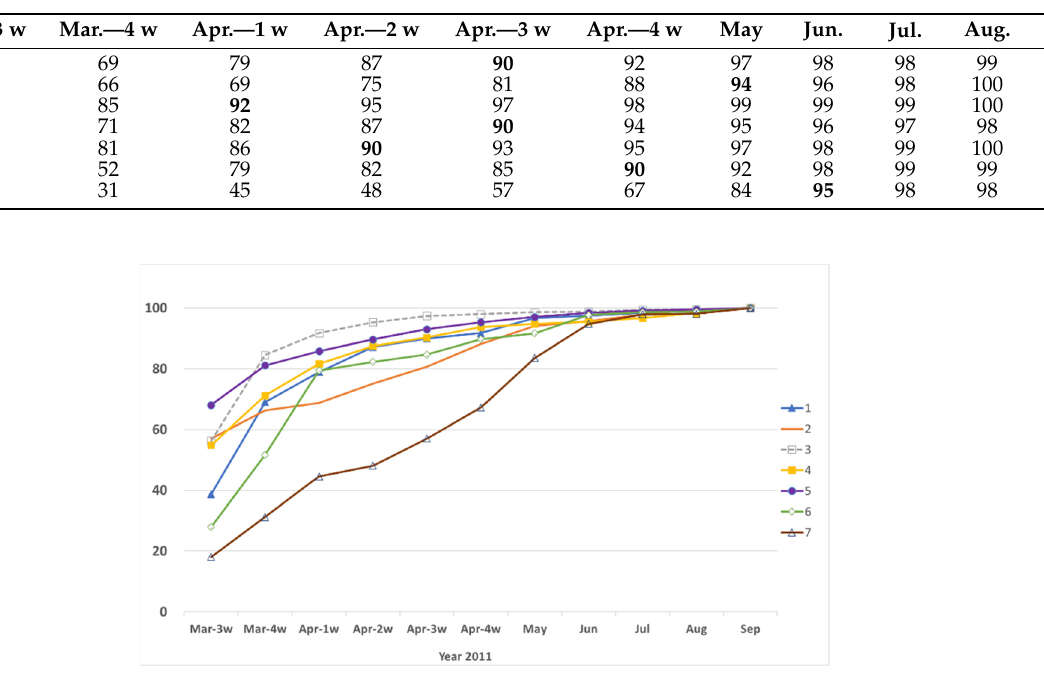
Table 4. The number of road recovery percentages in seven clusters of Fukushima.